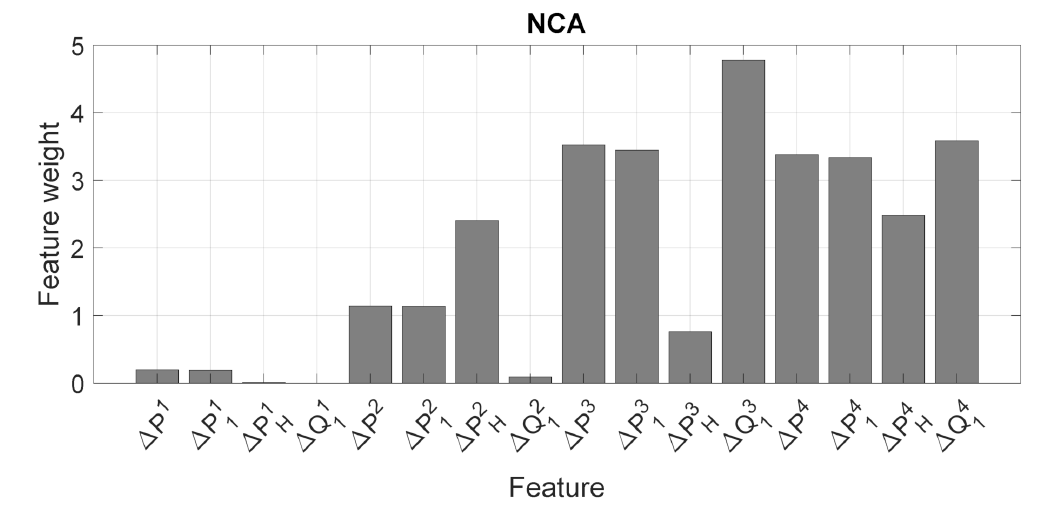
Figure 4. The feature weights obtained with the NCA algorithm. The weights of the irrelevant features are very close to zero. The superscript identifies the observation window after the event.